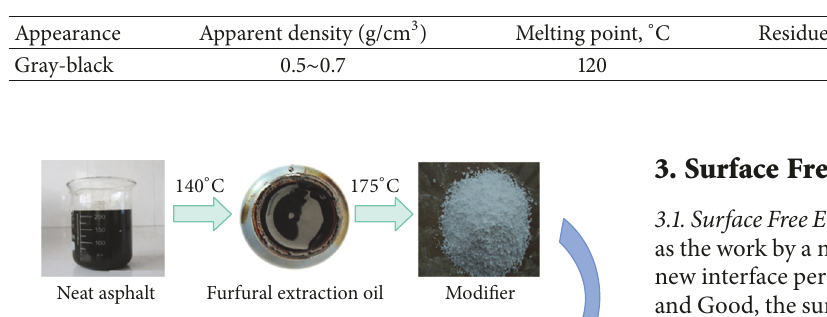
Table 4: Properties of stabilizer.